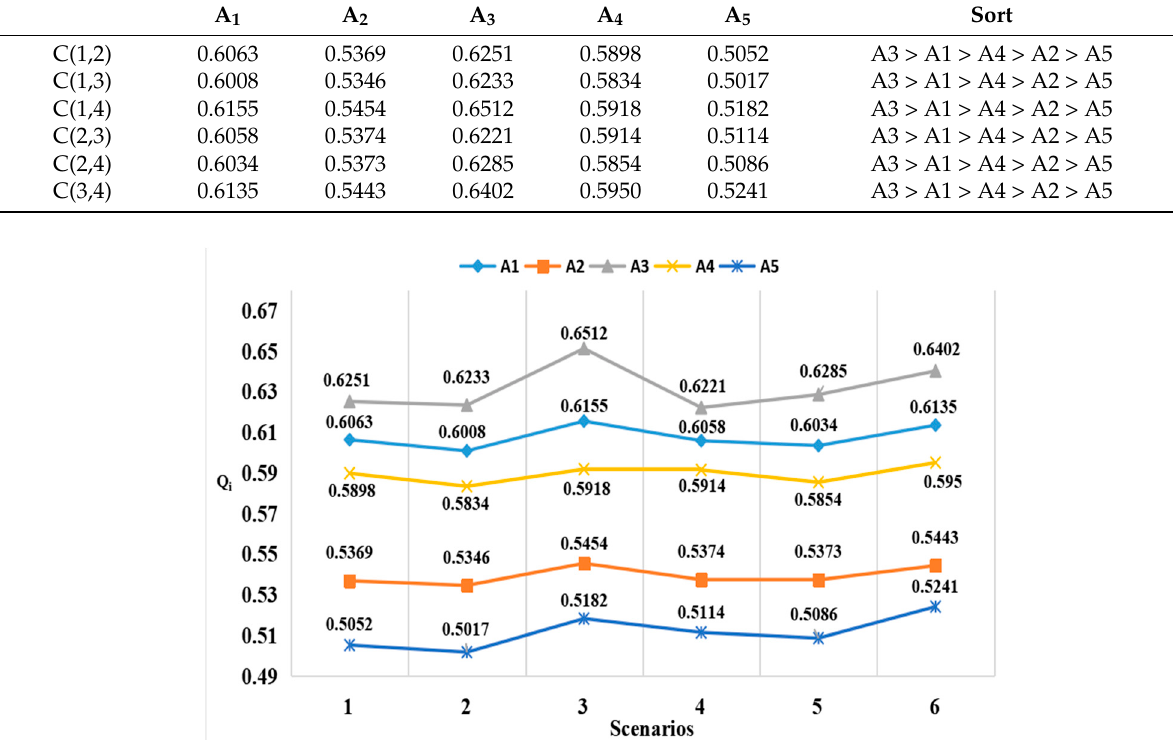
Figure 2. Sensitivity analysis of rankings by Q i . Table 12. Sensitivity rankings of N i ( % )